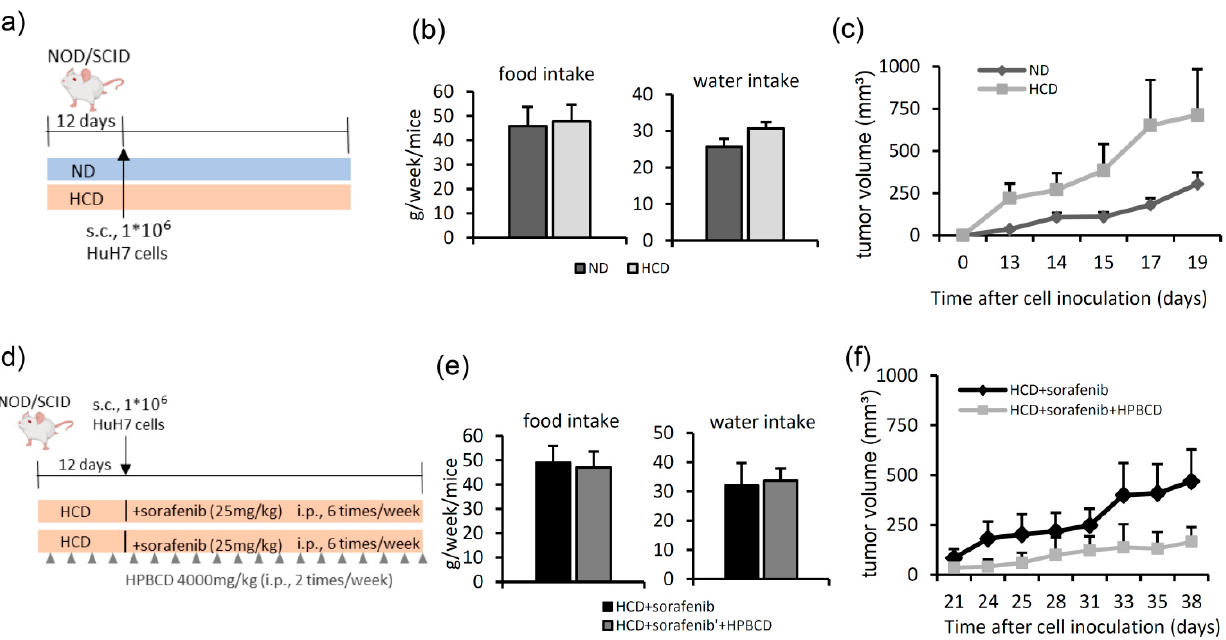
Figure 4. Free cholesterol-lowering agent treatment improves sorafenib’s tumor-inhibiting ability in the group fed a high-cholesterol diet. ( a ) Scheme of the experimental strategy of the effects of a normal diet (ND) and a high-cholesterol diet (HCD) on tumor growth. ( b , c ) Average food intake, water intake, and tumor sizes of the mice. All values are expressed as the mean ± SEM ( n = 5). ( d ) Scheme of the experimental strategy of the effects of free cholesterol-lowering drug (2-hydroxypropyl- β -cyclodextrin (HPBCD)) plus sorafenib in a hepatocellular carcinoma (HCC) xenograft model fed an HCD. ( e , f ) Average food intake, water intake, and tumor sizes of mice. All values are expressed as the mean ± SEM ( n = 5).